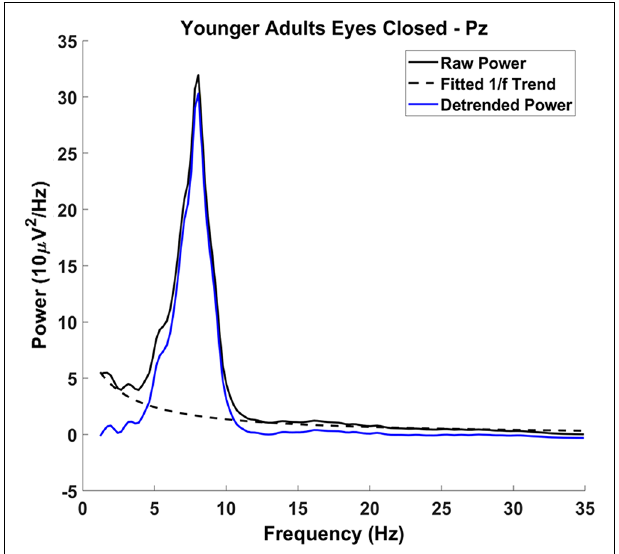
FIGURE 2 | Detrending procedure: raw power spectrum (solid black line), with the characteristic 1/ f phenomenon across the spectrum. The 1/ f phenomenon was modeled excluding the frequencies 4–13 Hz (dashed black line) and was subtracted from the raw power spectrum, resulting in the detrended power spectrum (solid blue line). Alpha and theta measurements were made on the detrended power spectrum.